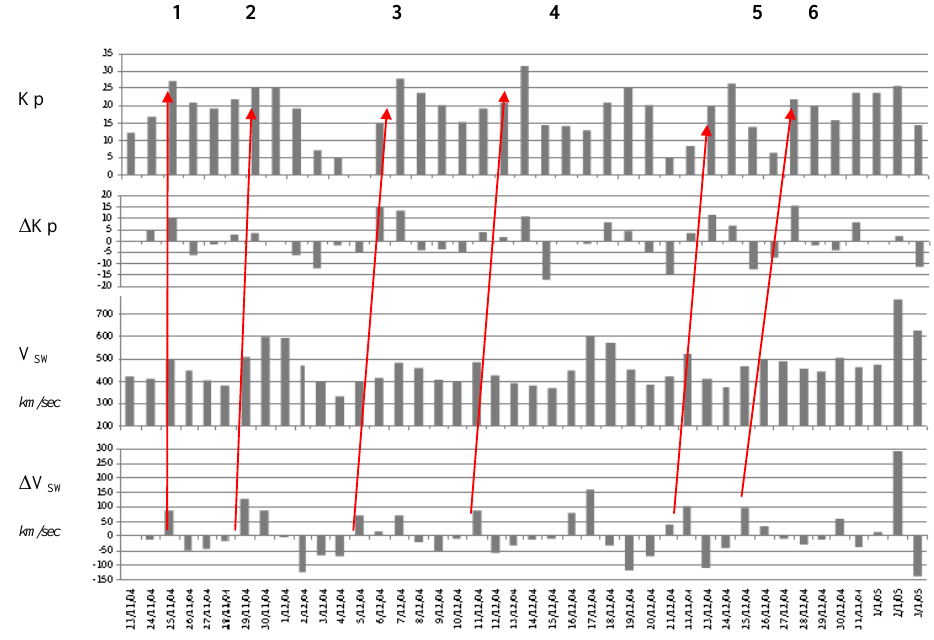
Fig. 4. Daily values of the geomagnetic index K p (top panel) and the daily average solar wind speed V (third panel from the top) along with the corresponding daily rates of variations 1K p (middle panel) and 1V (bottom panel). The normal arrows indicate the enhanced geomagnetic activity following solar wind speed increases for all 6 significant earthquakes (#1–6).